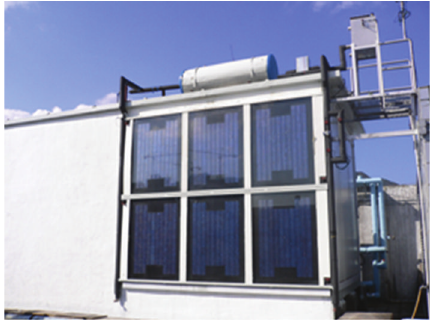
Figure 3: Front view of BiPV/T system with water tank at top of wall.